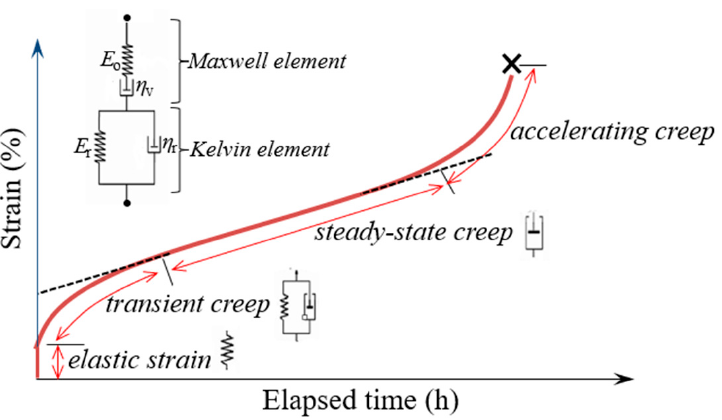
Figure 1. Typical creep behavior of a material, and the corresponding Burgers